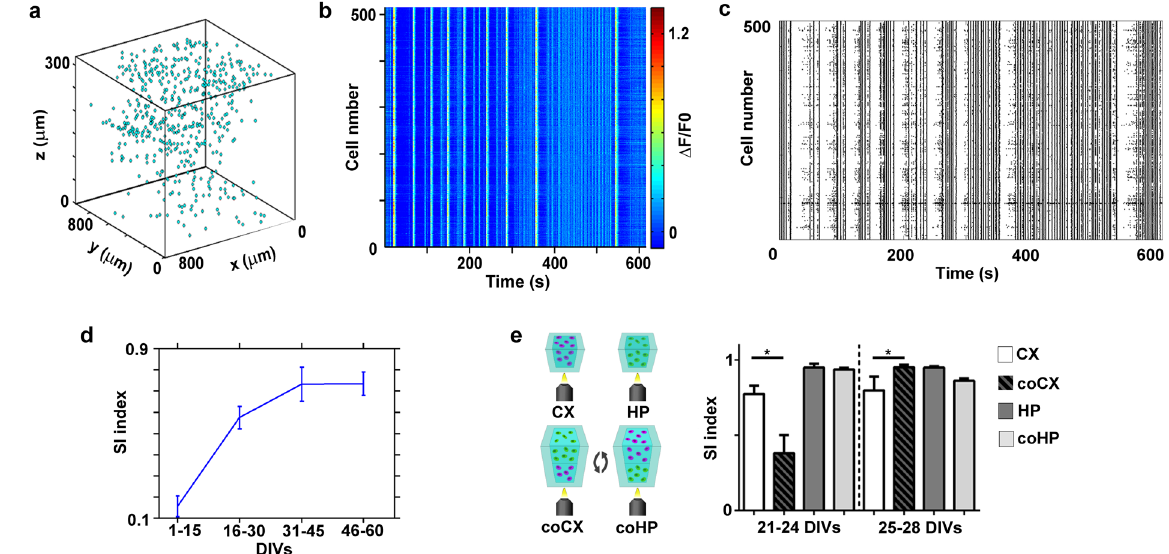
Figure 5. Structural and functional reconstruction of a representative 3D cortical network. ( a ) 3D representation of the cell somata positions, within the acquired volume portion of the 3D cortical neuronal network at 24 DIVs; ( b ) Δ F/F pseudo-color plot of the identified cells of the network shown in a ). ( c ) raster plot of the same network as in a) and b) constructed after the automated calcium event detection analysis. ( d ) Plot showing the synchronicity index (SI) of 3D cortical cultures over time; data shown are the mean values ± standard errors (n = 17 for each group of DIVs); ( e ) On the left, a scheme of the optical monitoring layout of the compared conditions is shown (CX = cortical network analyzed in single cultures, HP = hippocampal network analyzed in single cultures, coCX = cortical network analyzed in layered co- cultures, coHP = hippocampal network analyzed in layered co-cultures). On the right, bar plot showing the synchronicity index (SI) of single and layered co-cultures at early and late DIVs; data shown are the mean values + standard errors (n = 7 for each group at 21–24 DIVs, and n = 13 for each group at 25–28 DIVs). Note that the data were grouped differently than in Fig. 4 to facilitate the comparison among different preparations (e.g. we managed to record only one co-culture at 36